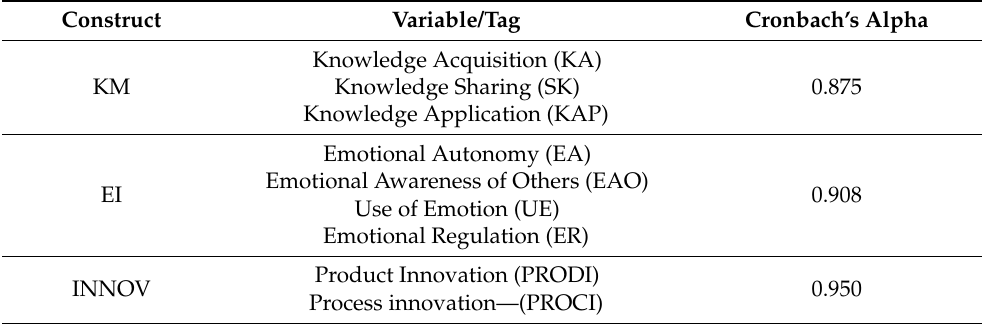
Table 2. Cronbach’s Alpha.